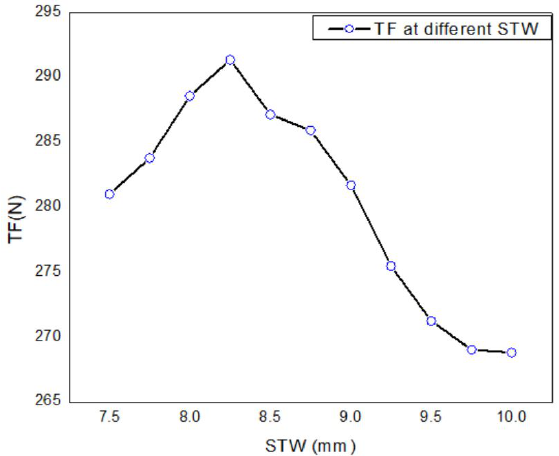
Figure 15. Influence of stator tooth width on